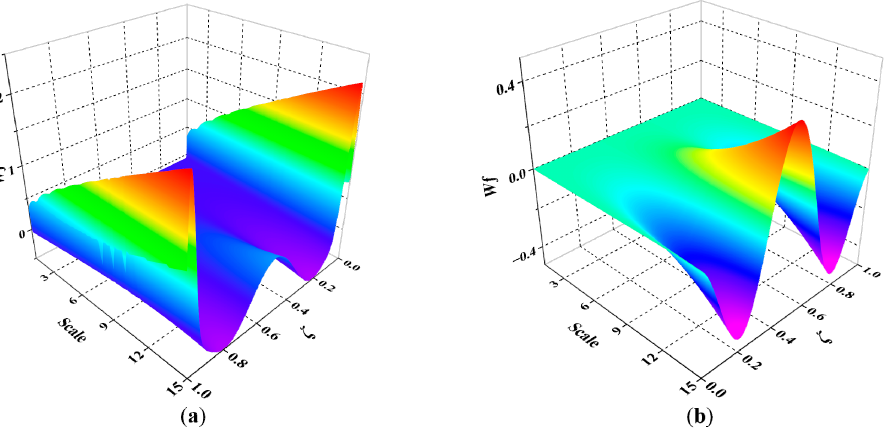
Figure 3. Third CWT mode shape of the FF beam: ( a ) no boundary extension; ( b ) boundary exten- sion.